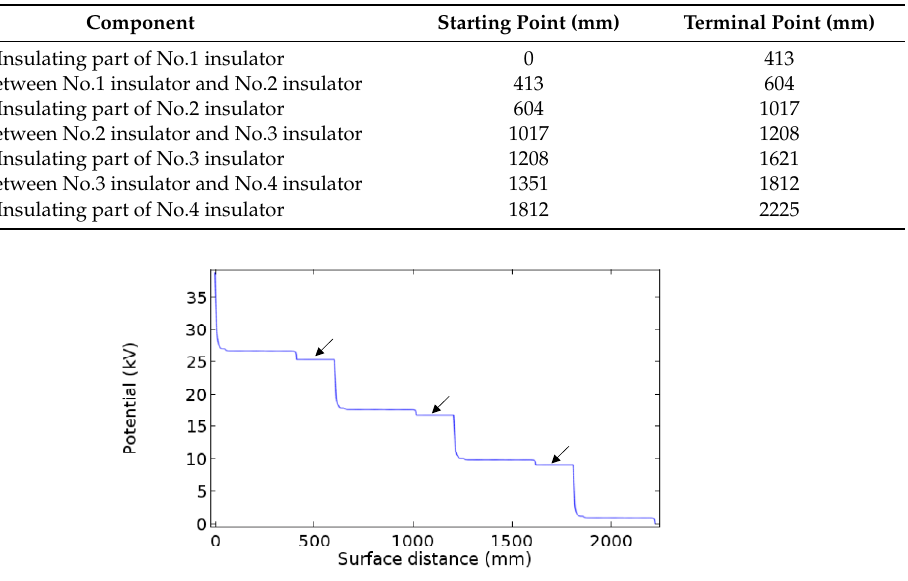
Table 3. Corresponding surface distance of each part of the insulator string.